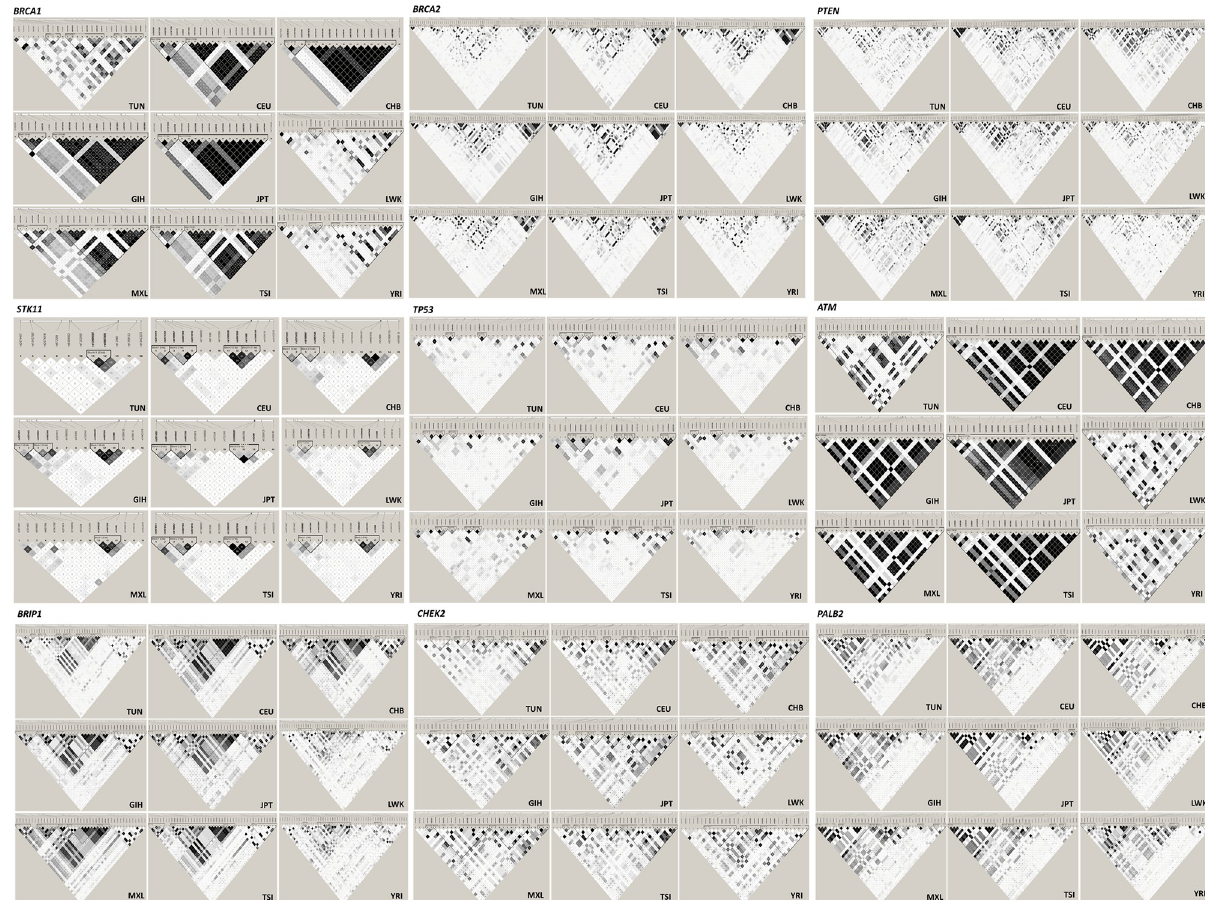
Fig 1. LD patterns and haplotype structure of high and moderate penetrance breast cancer susceptibility genes in the Tunisian population and 8 populations of the 1000 genomes project. LD blocks were constructed using Haploview program version 4.2. In each box the intensity of the shadow represents the increasing strength of LD. White blank boxes represent lack of LD while dark boxes signify strong LD patterns. Tagging SNPs are highlighted in bold.